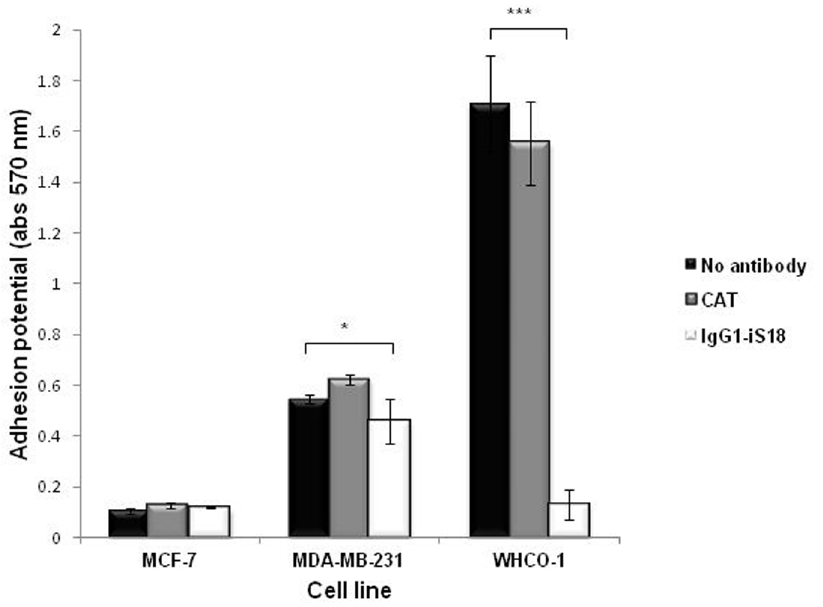
Figure 4. Effect of anti-LRP/LR specific antibody IgG1-iS18 on the adhesive potential of breast and oesophageal cancer cells. Cells were incubated with IgG1-iS18 (0.2 mg/ml) and CAT acting as a negative control (0.2 mg/ml) for an hour on laminin-1 coated wells. Cells that had adhered were stained with crystal violet and absorbance of extracted dye was measured at 570 nm. A significant decrease in adhesion potential was noted for both WHCO1 and MDA-MB 231 cells upon application of IgG1-iS18 (light gray) compared to the no antibody control (black). Data are representative of three experiments carried out in triplicate from different cell cultures.